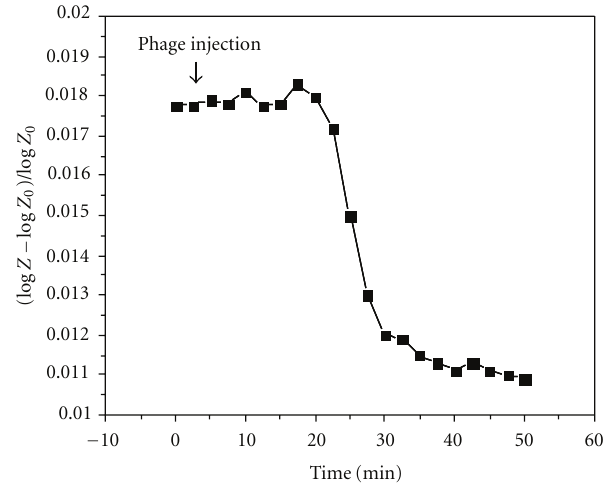
Figure 5: Variation of the absolute value of | (Log Z − Log Z 0 ) / Log Z 0 | after phage injection versus time at a fixed frequency of 233 mHz. E. coli bacteria concentration is 10 7 CFU/